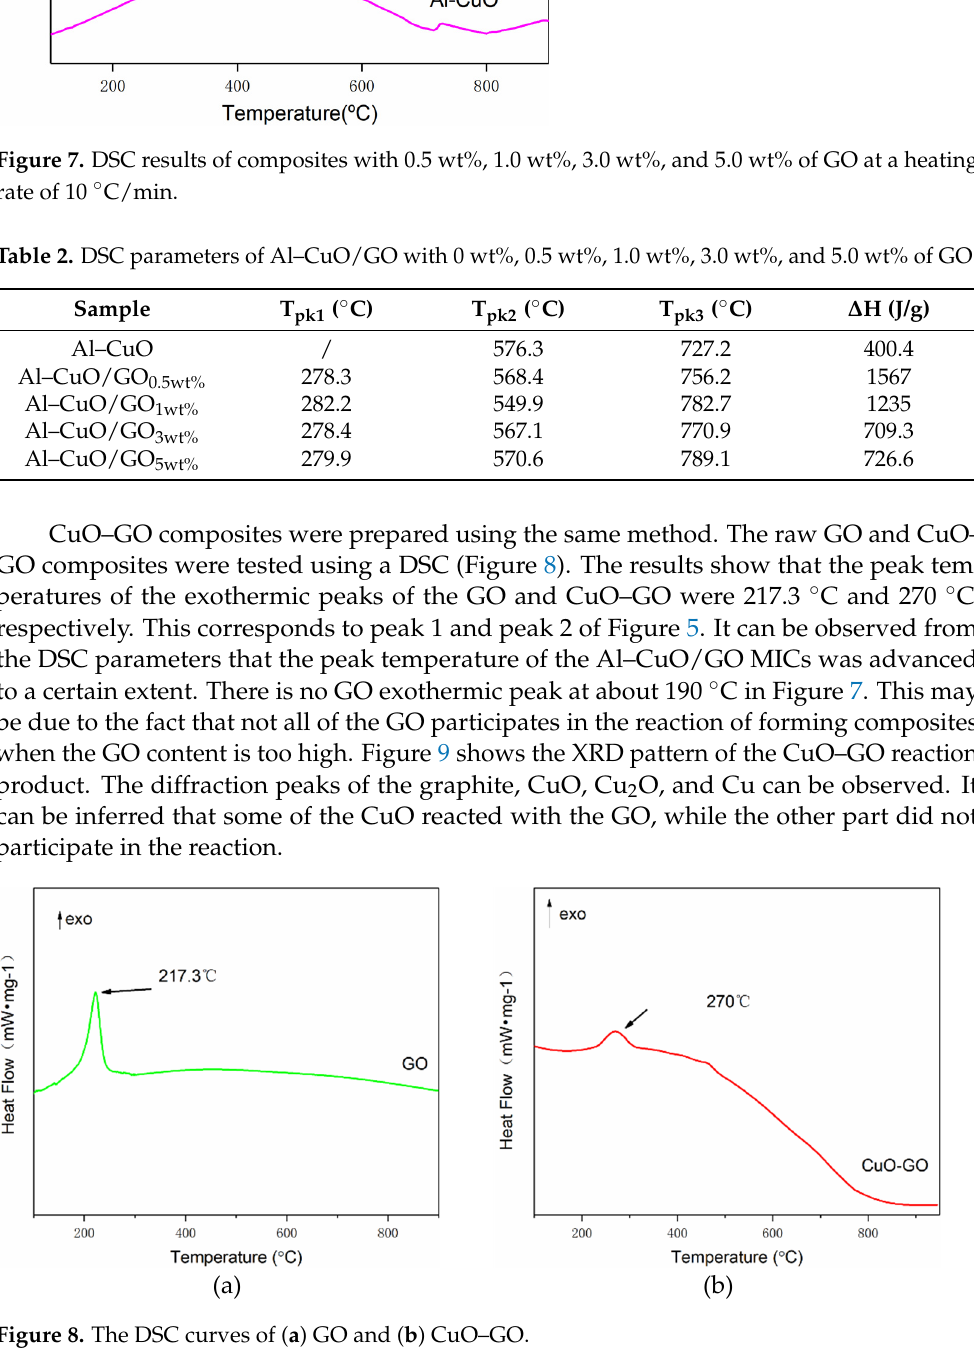
Figure 9. XRD pattern of the reaction products of CuO–GO. According to the previous analysis, we can conclude that the thermal reaction of the nanocomposites at about 570 °C was not a single thermite reaction. Figure 10 shows the reaction products of the nanocomposites (CuO:Al = 1.5:1, GO: 0.5 wt%) as characterized by XRD. Figure 10 shows the peaks of the CuAlO 2 , Cu 2 O, Cu, α -Al 2 O 3 , and γ -Al 2 O 3 . In addition, most alumina is likely to be amorphous, with wide peaks such as the one dis- played in Figure 10. Depending on the products observed, the entire reaction can be de- scribed by Equation (1). In addition, CuAlO 2 can be created by the reactions of Cu 2 O with Al 2 O 3 (as illustrated in Equation (2)) [39,40]. 5Al+9CuO → 6Cu+ Cu (cid:2870) O (cid:3397) 2Al (cid:2870) O (cid:2871) (cid:3397) CuAlO (cid:2870) (1) C u (cid:2870) O (cid:3397) A l (cid:2870) O (cid:2871) → 2CuAlO (cid:2870)